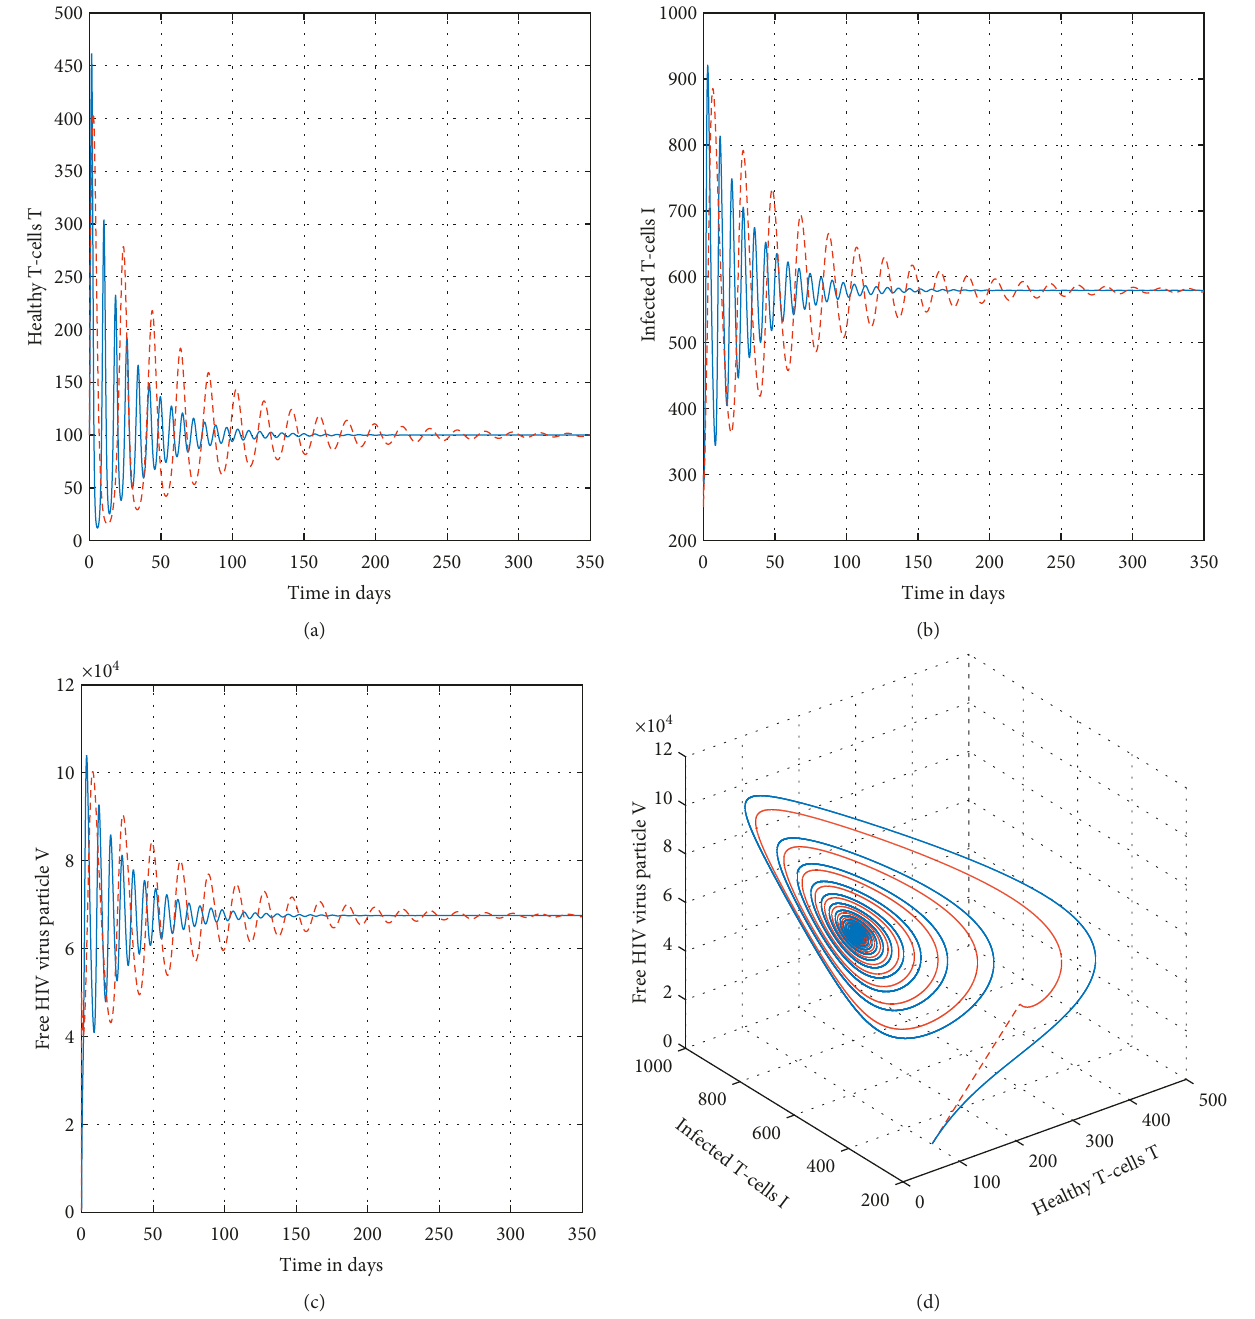
Figure 1: Graphical view analysis of the fractional model (2) of HIV by taking the index of memory ϑ � 0 .